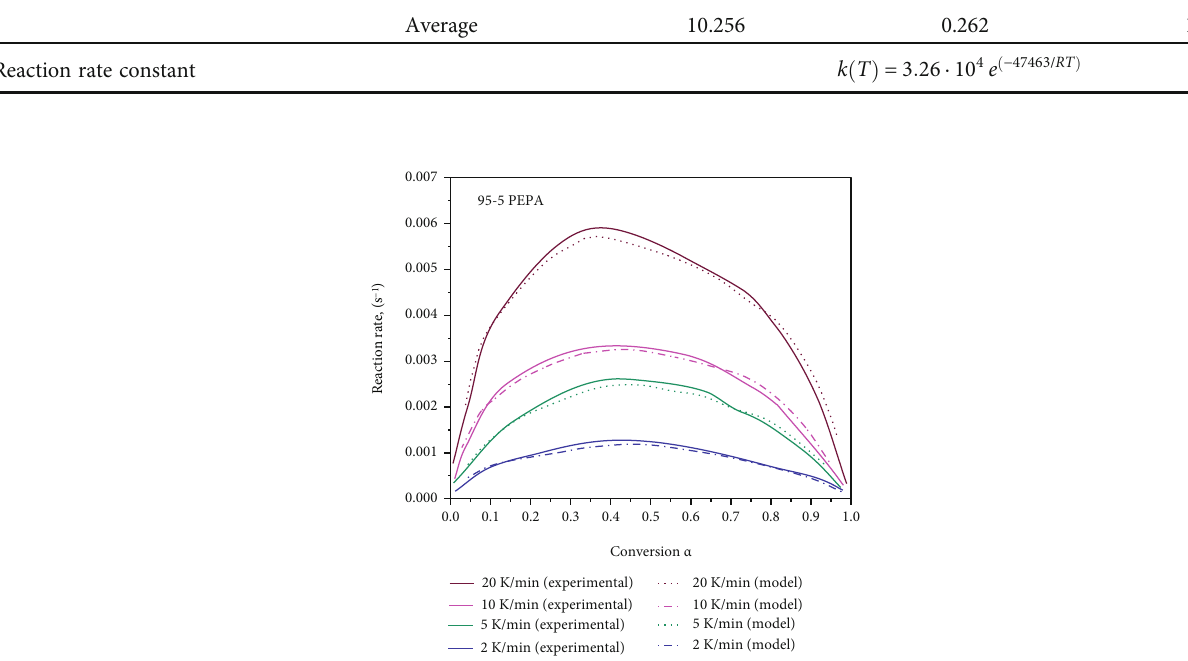
Figure 8: The autocatalytic model is compared to the experimental